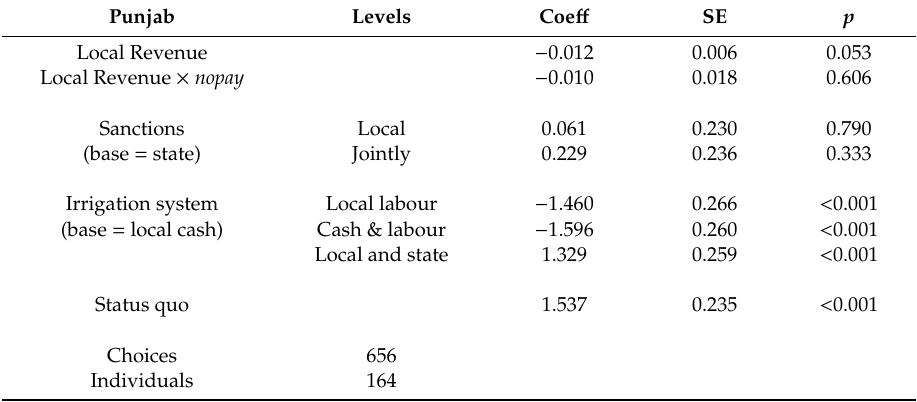
Table 13. Conditional logit estimates for preferences for governance structures: Punjab.